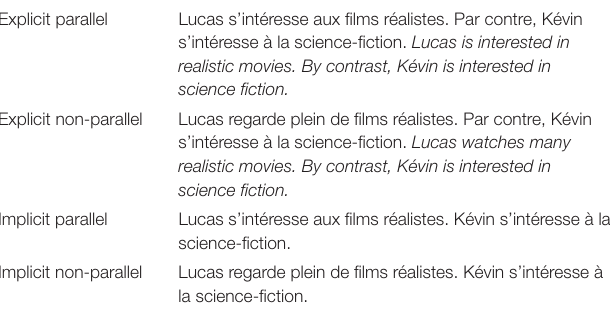
TABLE 1 | Conditions for Experiment